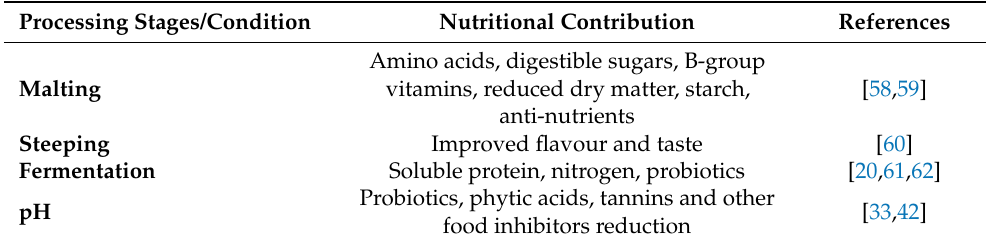
Table 2. Nutritional contribution at different processing stages and